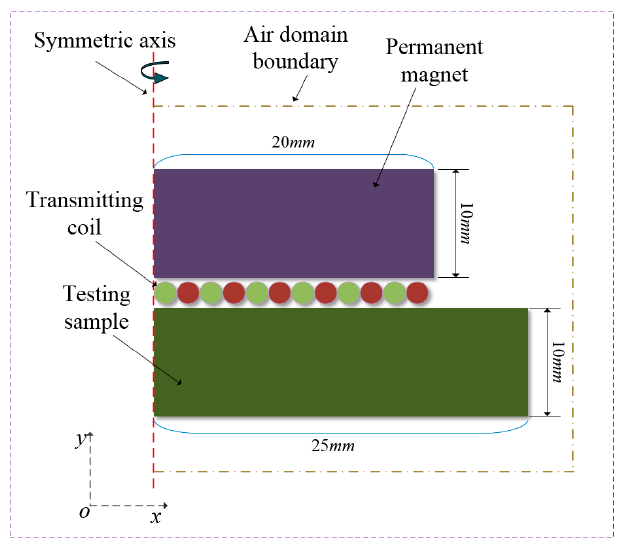
Figure 3. Geometrical schematic of a two -dimensional (2-D) axis-symmetric model.